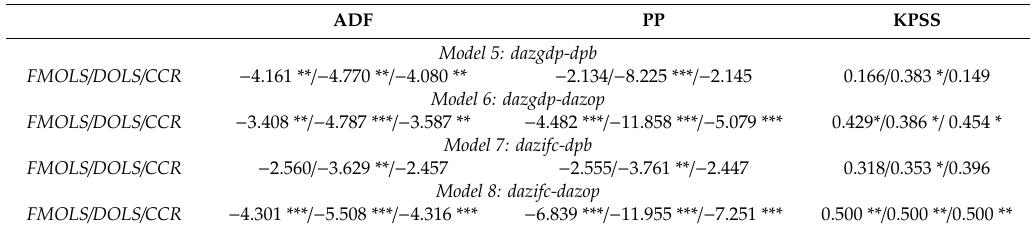
Table A20. AZ. The Unit Root test results